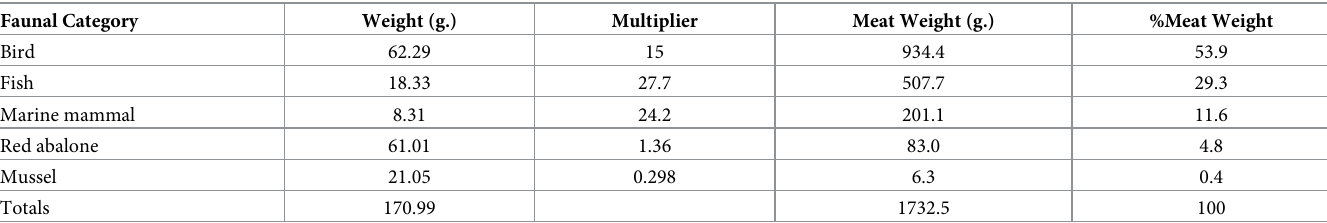
Table 3. Estimated edible meat yields for faunal remains recovered from the ~11,700 year old Paleocoastal component at CA-SRI-26. Faunal